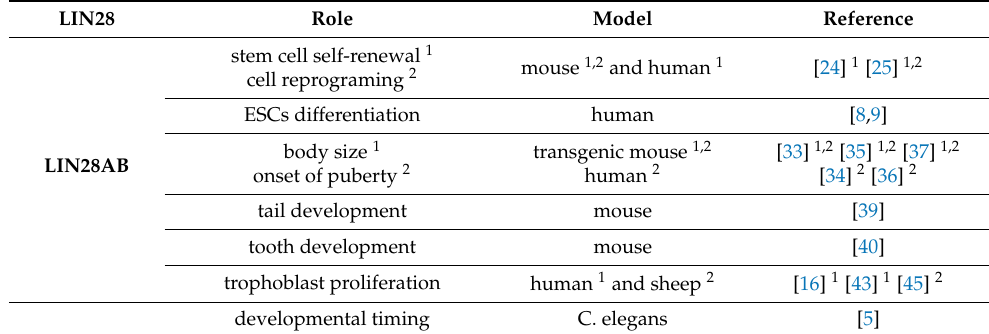
Table 1. The role of LIN28AB in various cells and